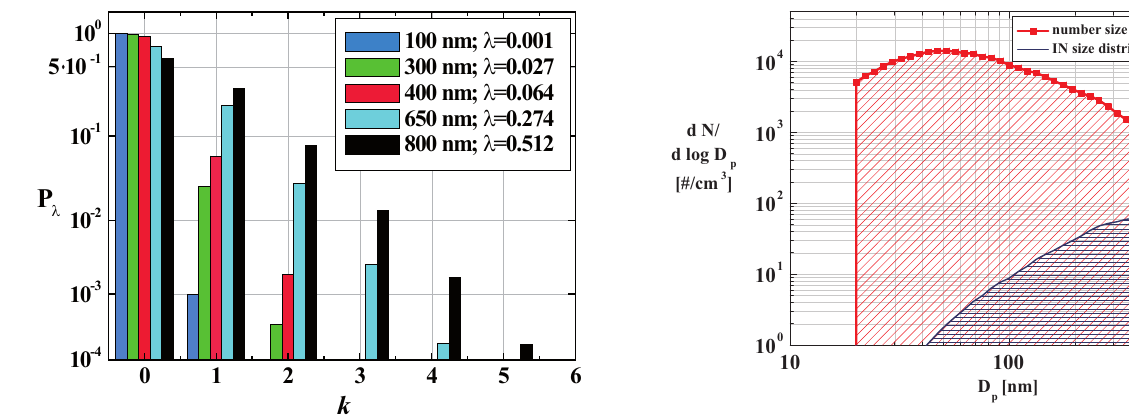
Fig. 6. Number size distribution of particles generated from a Snomax TM solution/suspension n 0 and derived IN size distribution n